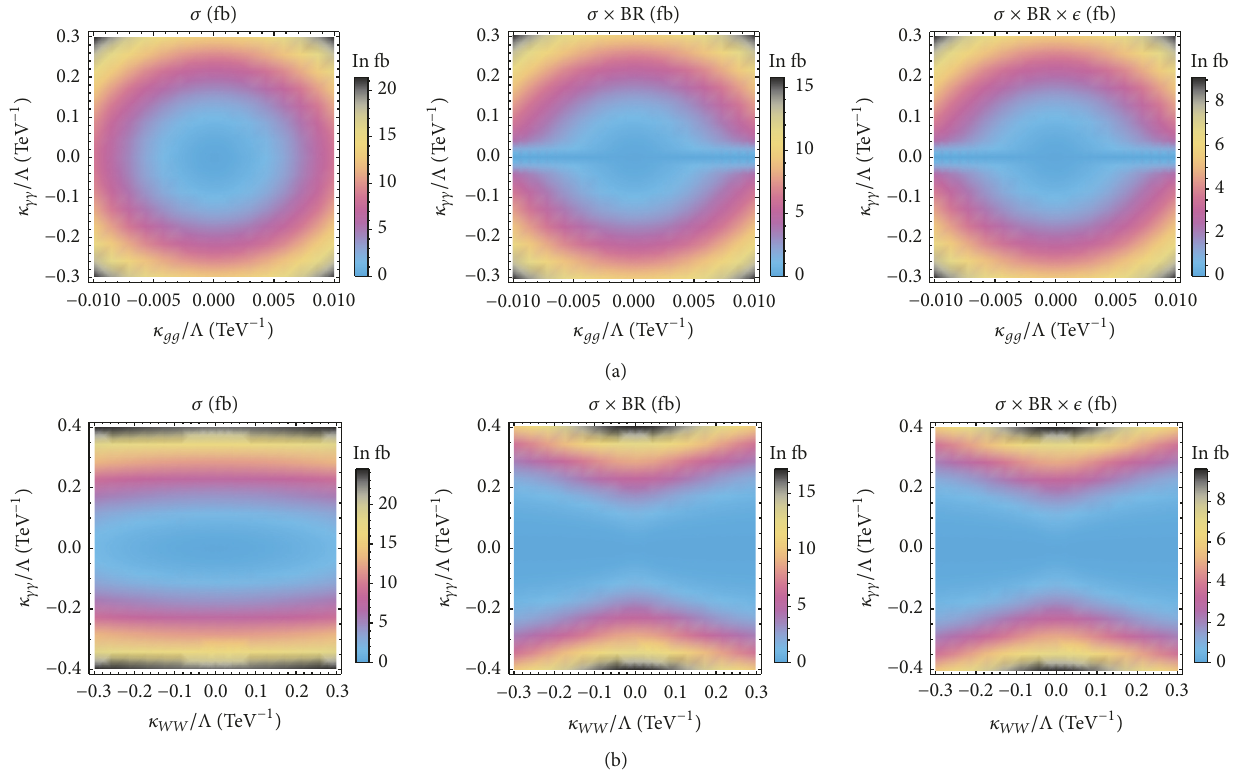
Figure 5: 2D plots of 𝜎 , 𝜎 × BR, and 𝜎 × BR × 𝜖 for 𝑀 Φ = 1 TeV for two coupling assumptions: 𝜅 𝑔𝑔 , 𝜅 𝛾𝛾 ̸= 0 (a) and 𝜅 𝑊𝑊 , 𝜅 𝛾𝛾 ̸= 0 (b) while setting other 𝜅 𝑥𝑦 to